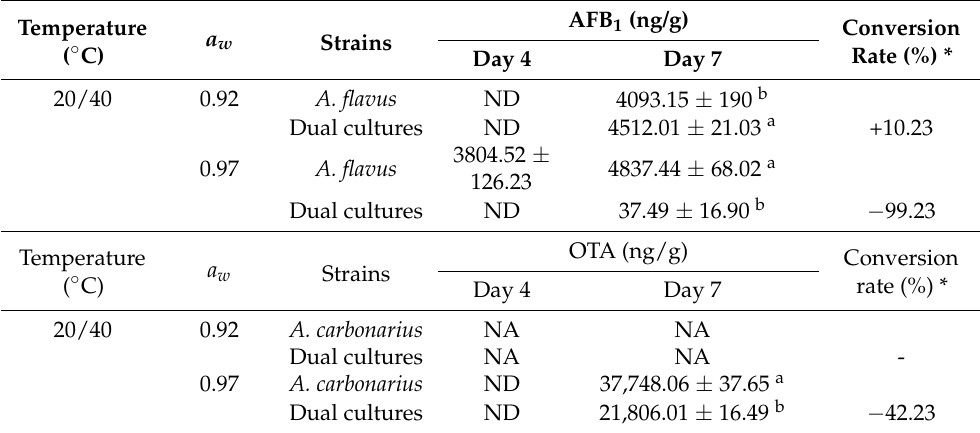
Table 4. AFB 1 and OTA production by A. flavus and A. carbonarius on single and dual cultures with A. oryzae on chili-based agar with 0.92 a w and 0.97 a w for 4 and 7 days at 20/40 ◦ C.